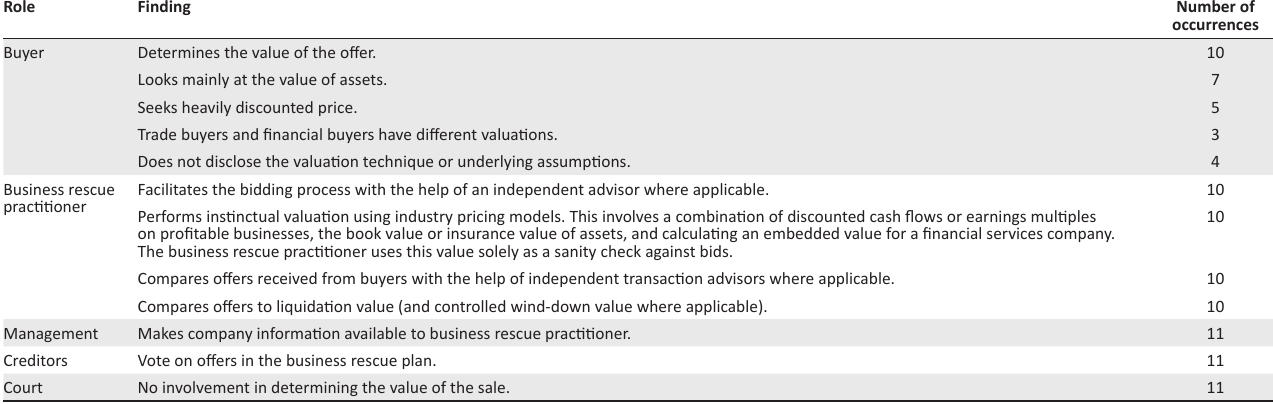
TABLE 1: Roles within the business rescue valuation